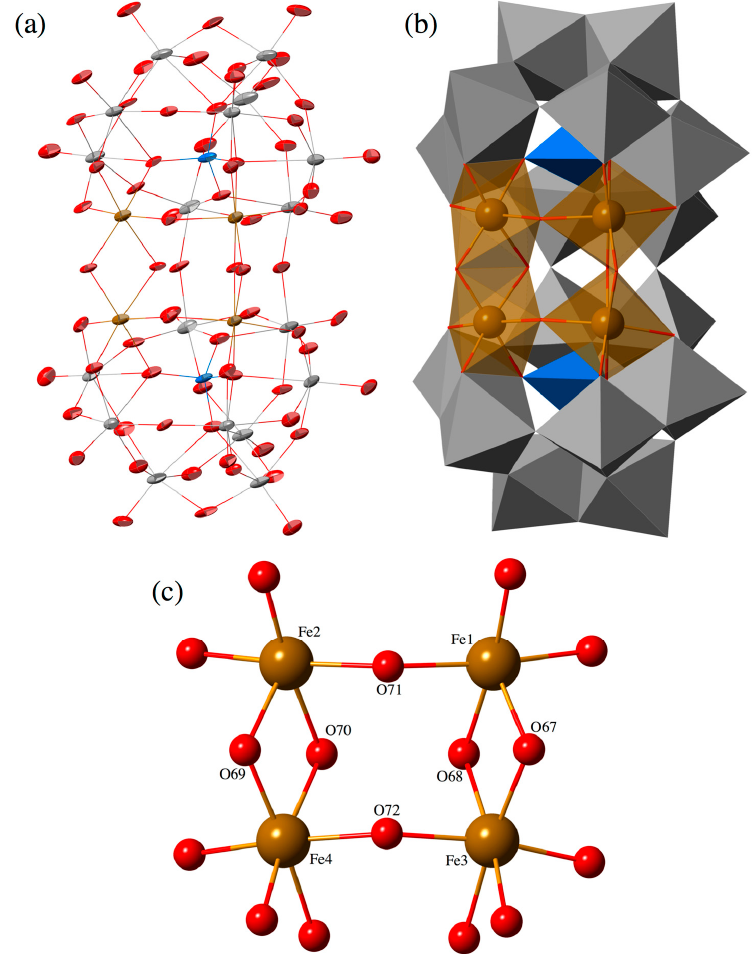
Figure 2. ( a ) Molecular structure of the polyoxoanion [{Fe 4 (H 2 O)(OH) 5 }( β , β -Si 2 W 18 O 66 )] 9 − of potassium salt of β , β -Fe 4 -open ; ( b ) its polyhedral representation; and ( c ) the partial structure around the Fe 4 center. Color code: Fe, brown; O, red; Si, blue; W, gray.